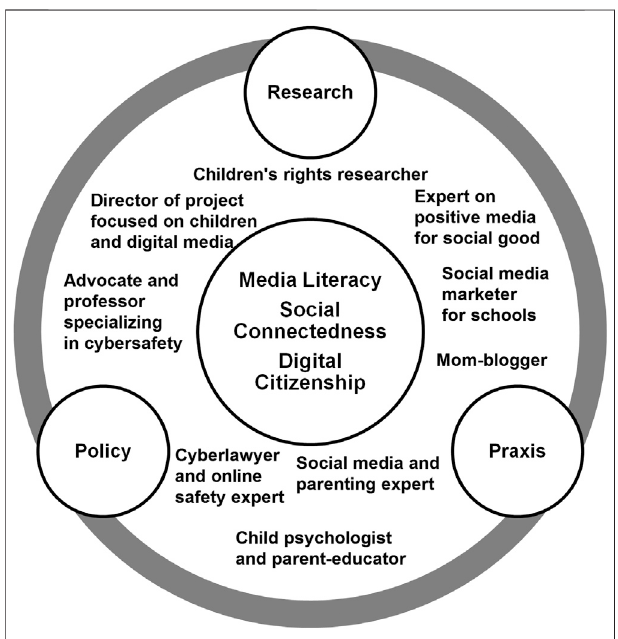
FIGURE 1 | Participants ’ positions across the policy-praxis- research